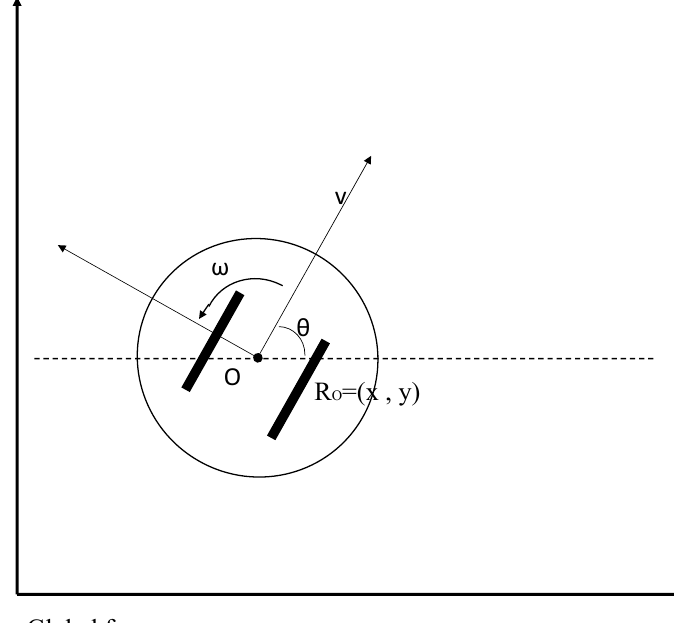
Figure 1. The kinematic model of a mobile robot.